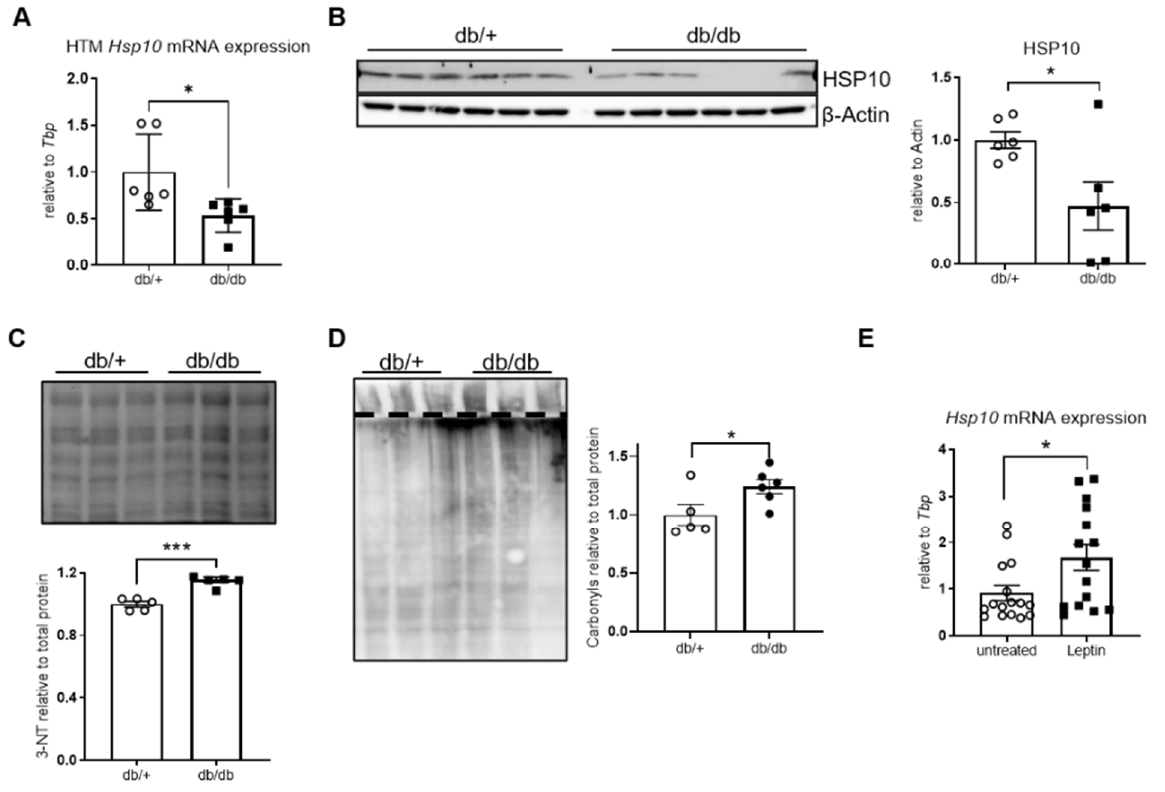
Figure 1. Metabolic regulation of Hsp10 and its dysregulation in a model of type 2 diabetes (T2D). ( A ) mRNA expression analysis of Hsp10 in the HTM of db/db mice and ( B ) Western blot and densitometric analysis of mitochondrial fraction from db/db mice brains. n = 6 for db/+ and n = 6 for db/db. ( C ) Representative Western blot (3 vs. 3) and densitometric analysis of protein oxidation (3-nitrotyrosine) of all analyzed db/db mice brains. n = 5 for db/+ and n = 6 for db/db. ( D ) Representative Western blot (3 vs. 3) and densitometric analysis of protein oxidation (carbonylation) of db/db mice brains. n = 5 for db/+ and n = 6 for db/db. ( E ) mRNA expression of Hsp10 of serum-starved control and leptin-treated SH-ObRb cells for 6 h, n = 18. *, p < 0.05, ***, p < 0.001 after two-tailed Student’s t -test. All data are presented as mean ± SEM.